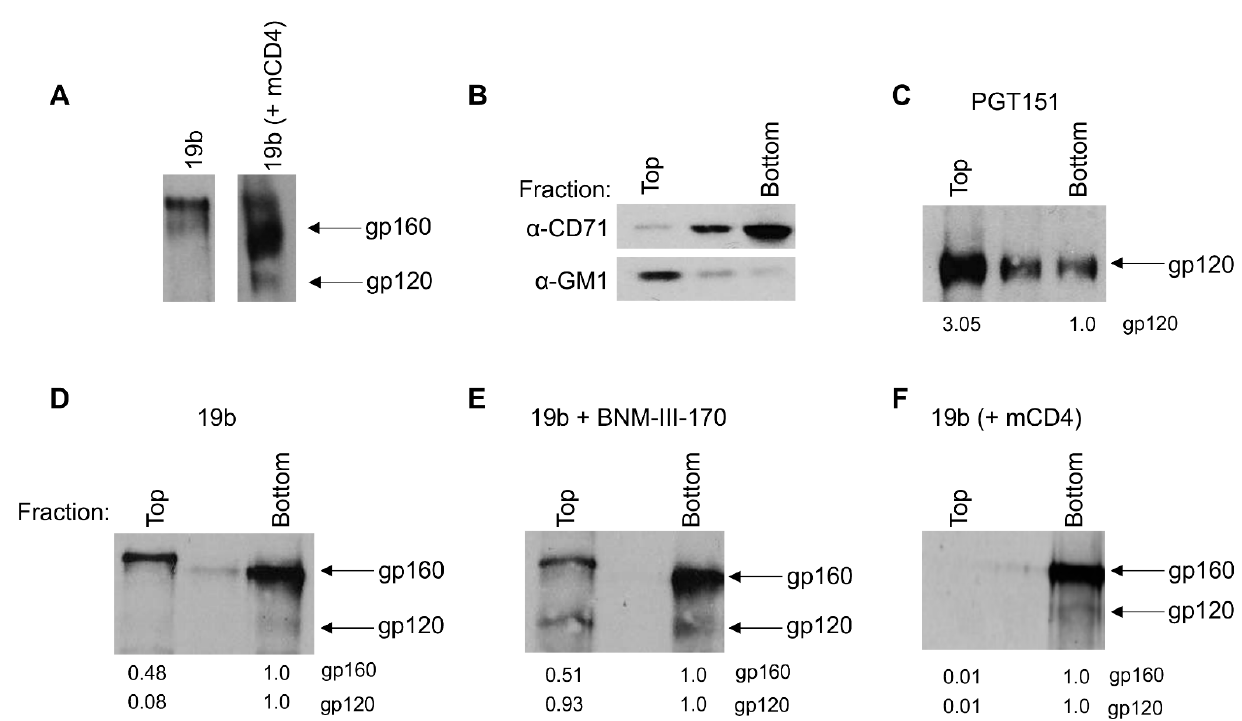
Figure 3. Differential localization of antibody–Env complexes visualized by lipid microdomain fractionation. The 293T cells were transfected with a plasmid encoding JRFL Env alone or together with an expressor of the human CD4 receptor and 48-h post-transfection all cell surface proteins were biotinylated. ( A ) Immunoprecipitation of cell surface biotinylated Env from cells transfected to express the (left) JRFL Env alone or (right) with the human CD4 receptor after incubation with 19b. Further, cell lysates were fractionated on a sucrose density gradient as described in Materials and Methods. ( B ) Equal volumes of individual fractions were resolved by SDS-PAGE, transferred to a nitrocellulose membrane, and probed with HRP-conjugated CTx-B to detect DRM marker ganglioside GM1 or with OKT-9 antibody to detect DSM marker CD71. ( C – F ) Immunoprecipitation of cell surface biotinylated Env from individual sucrose gradient fractions using ( C ) PGT151, ( D ) 19b, ( E ) 19b with 5µM BNM-III-170 from cells expressing the JRFL Env only and ( F ) 19b from cells expressing both the JRFL Env and human CD4 receptor. Values represent densities of respective band intensities quantified using ImageJ normalized to the bottom fractions. ( B – F ) Representative blots from at least three independent experiments are shown. mCD4; membrane-anchored CD4.